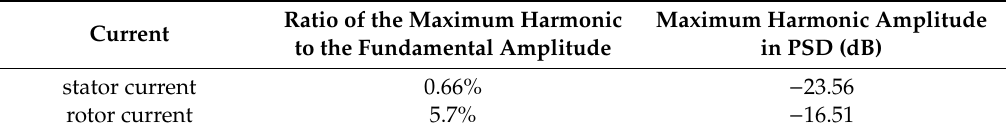
Figure 10. Rotor current comparison under the aerodynamic imbalance. Table 2. Harmonic amplitude comparison between stator and rotor current.